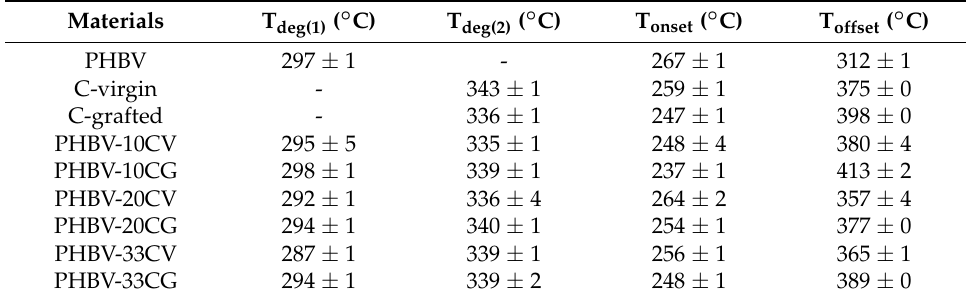
Figure 2. TG and DTG curves of C-virgin ( - ), C-grafted ( - ), PHBV ( - ), PHBV-20CV ( ··· ), PHBV-20CG ( ··· ), PHBV-33CV ( - - ), and PHBV-33CG ( - - ) under N 2 . Table 2. Thermal degradation temperature of PHBV-based